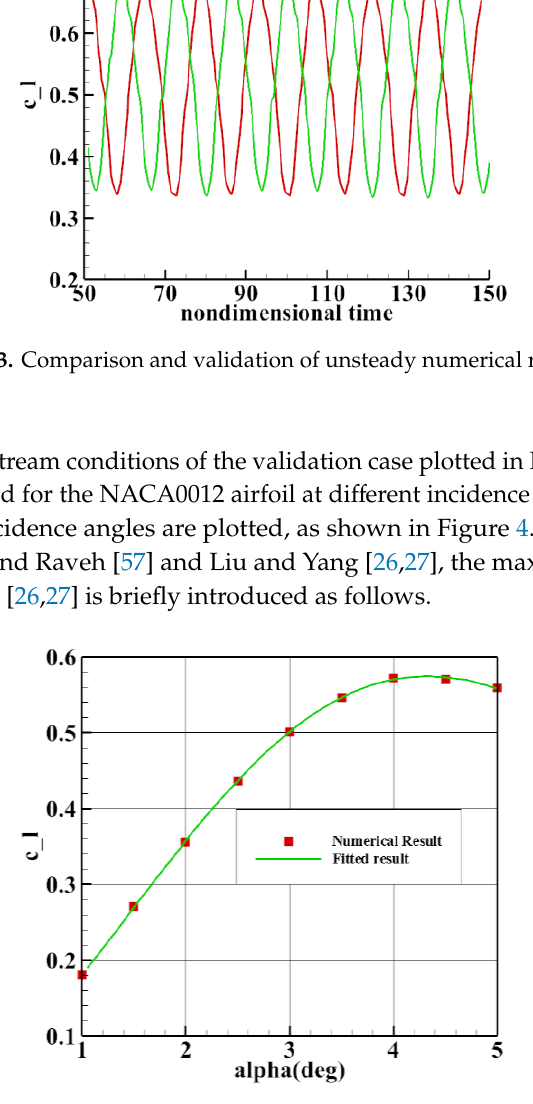
Figure 5. Grid of a tangential blowing slot. With the blowing total pressure equaling the freestream total pressure, the lift coefficients at different incidence angles were compared with those of a clean airfoil, as plotted in Figure 6. Based on the maximum curvature method, the transonic buffet onset margin with “ 46% x/c ” blowing was found to be 4.5°, and its corresponding curvature was 0.04. It can be seen from Figure 6 that, at Mach 0.751 when the incidence angle is below 2.5°, the airfoil lift with tangential blowing was a little lower. When the incidence angle is greater than 3.0°, and especially when the lift slope of the airfoil without blowing is lower for incidence angles beyond 4.5°, the airfoil lift with tangential blowing was higher. Thus, tangential blowing can not only postpone the transonic buffet onset margin, but the airfoil lift can also be increased.